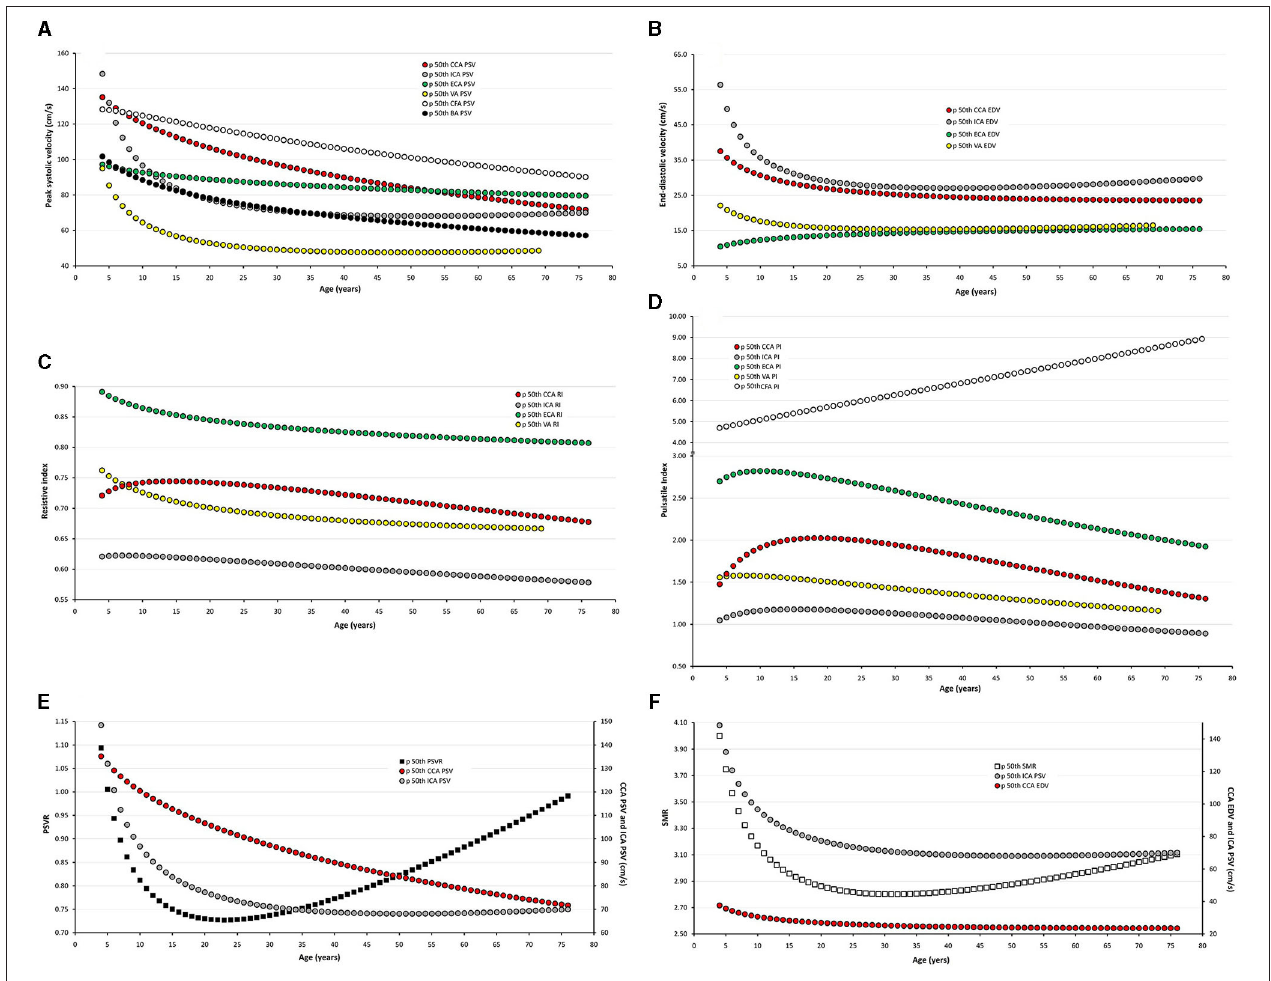
FIGURE 6 | Age-related percentile 50th curves for PSV (A) , EDV (B) , RI (C) , PI (D) , PSVR (E) , and SMR (F)